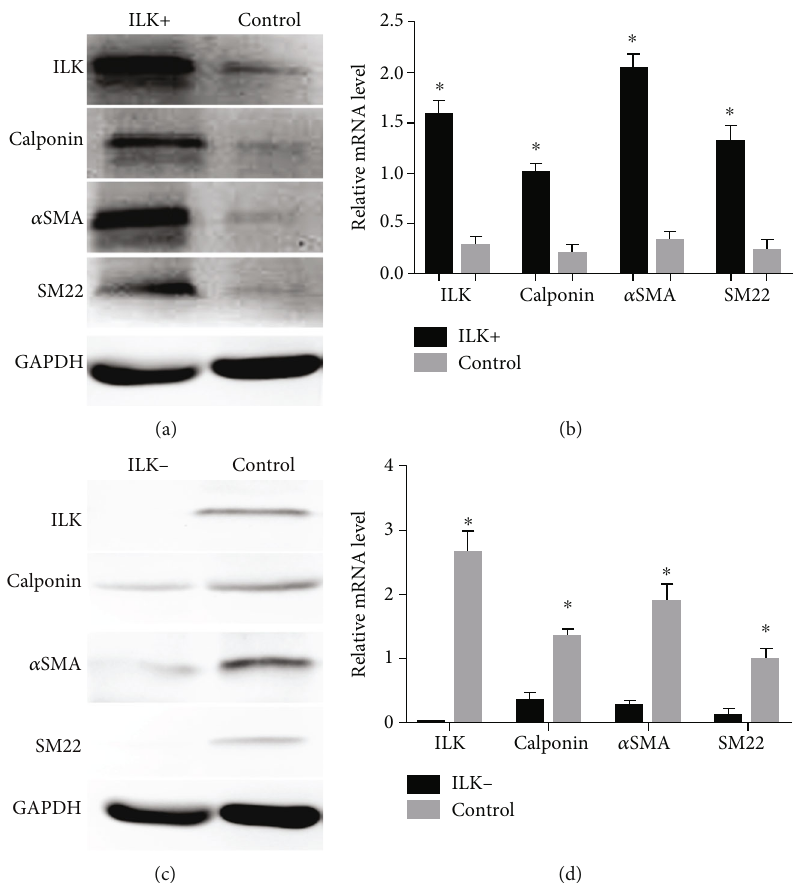
Figure 3: (a – d) ILK promotes the di ff erentiation of USCs to SMCs. Western blot and qRT-PCR of ILK, calponin, aSMA, SM22 in USCs with LPTP (ILK+), and control USCs were quanti fi ed to show relative protein and mRNA levels (a, b). Similarly, Western blot and qRT-PCR of ILK, calponin, aSMA, SM22 in USCs with knocking down ILK (ILK-), and control USCs were quanti fi ed to show relative protein and mRNA levels (c,